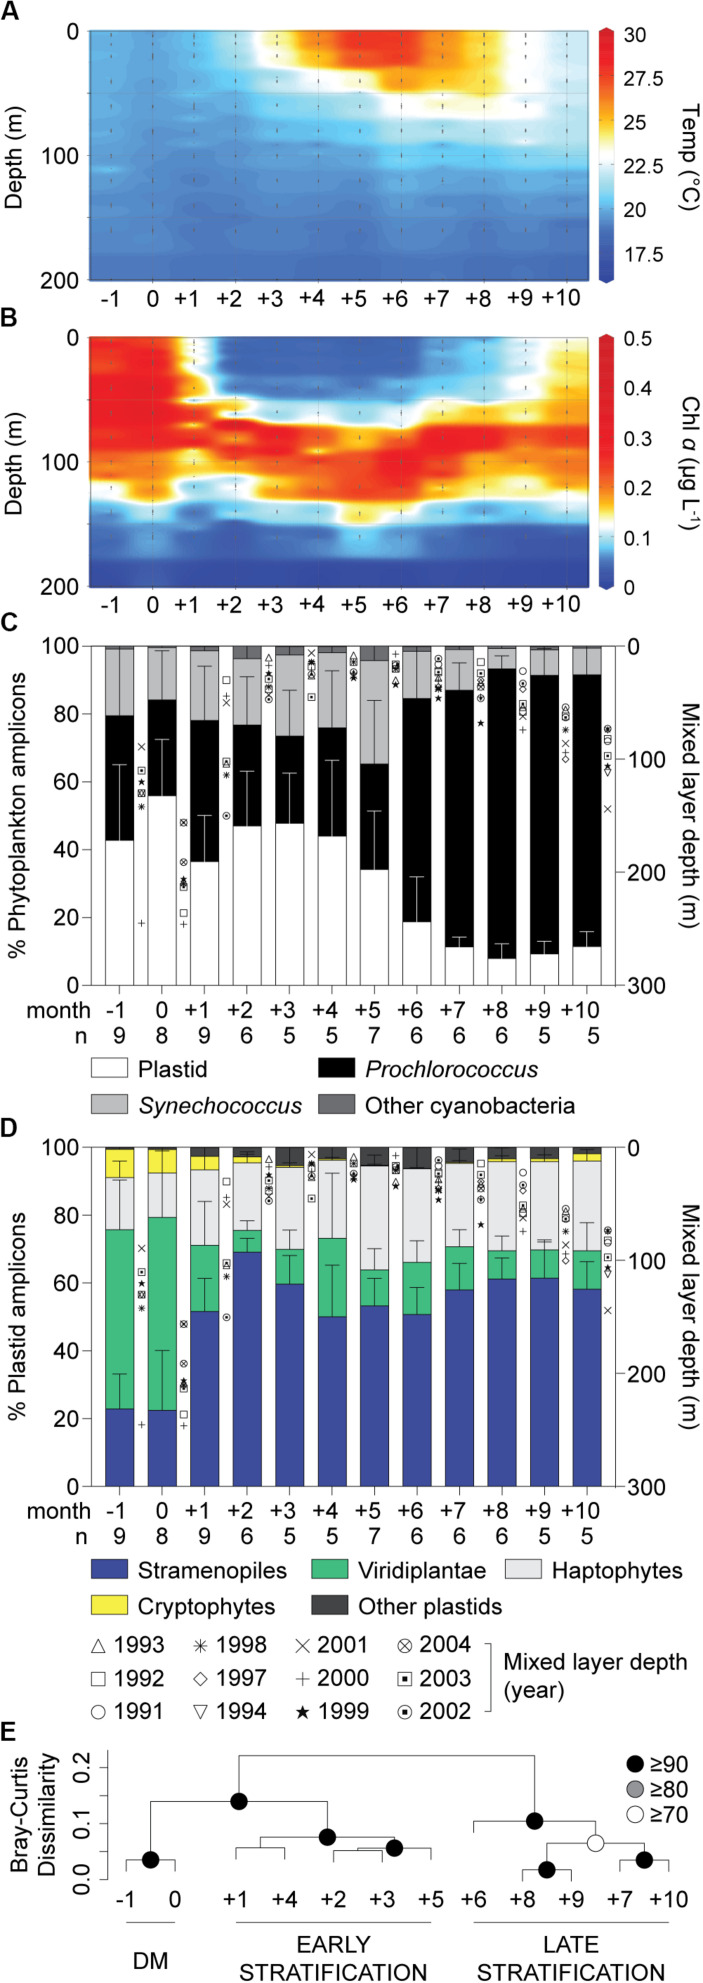
Characteristics of the water column and phytoplankton distributions in the northwestern Sargasso Sea. (A) Mean temperature and (B) chlorophyll a concentrations show the oceanographic details in this study site. (C) The relative abundance of overall phytoplankton 16S V1-V2 amplicons expressed as a percentage of amplicons phylogenetically assigned to plastids, Prochlorococcus, Synechococcus and other cyanobacterial groups and (D) major eukaryotic phytoplankton lineages illustrate broad spatiotemporal dynamics of phytoplankton diversity and distribution in surface waters. Integrated monthly data from 1991 to 2004 at the BATS site after adjusting to the month of the maximum mixed layer depth (month 0). (E) Hierarchical clustering analysis with Bray-Curtis dissimilarity based on the relative abundance of plastid amplicons after assignment to broad taxonomic groups alongside cyanobacterial amplicons in surface waters. Approximately unbiased (AU) probability values based on multiscale bootstrap resampling (10,000 replicates) were calculated and expressed as p-values (%). The annual transition from the deep mixing (DM) period to early (Early Stratification) and late stratified (Late Stratification) periods is indicated. Error bars represent the standard deviation. The number of samples used (with each having all data types) for developing unweighted means and pooled standard deviation is indicated by n.